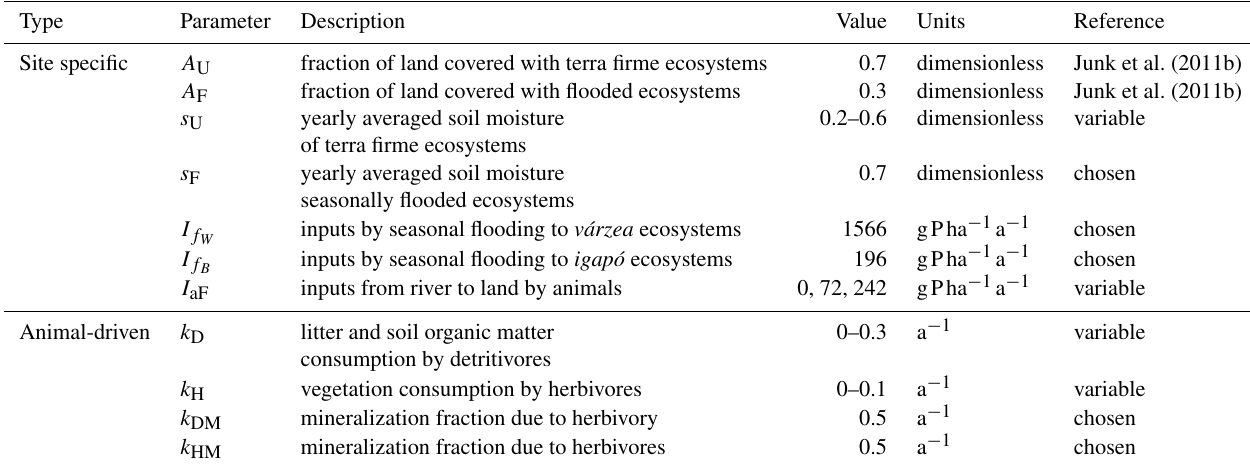
Table 3. Description of model parameters that are site